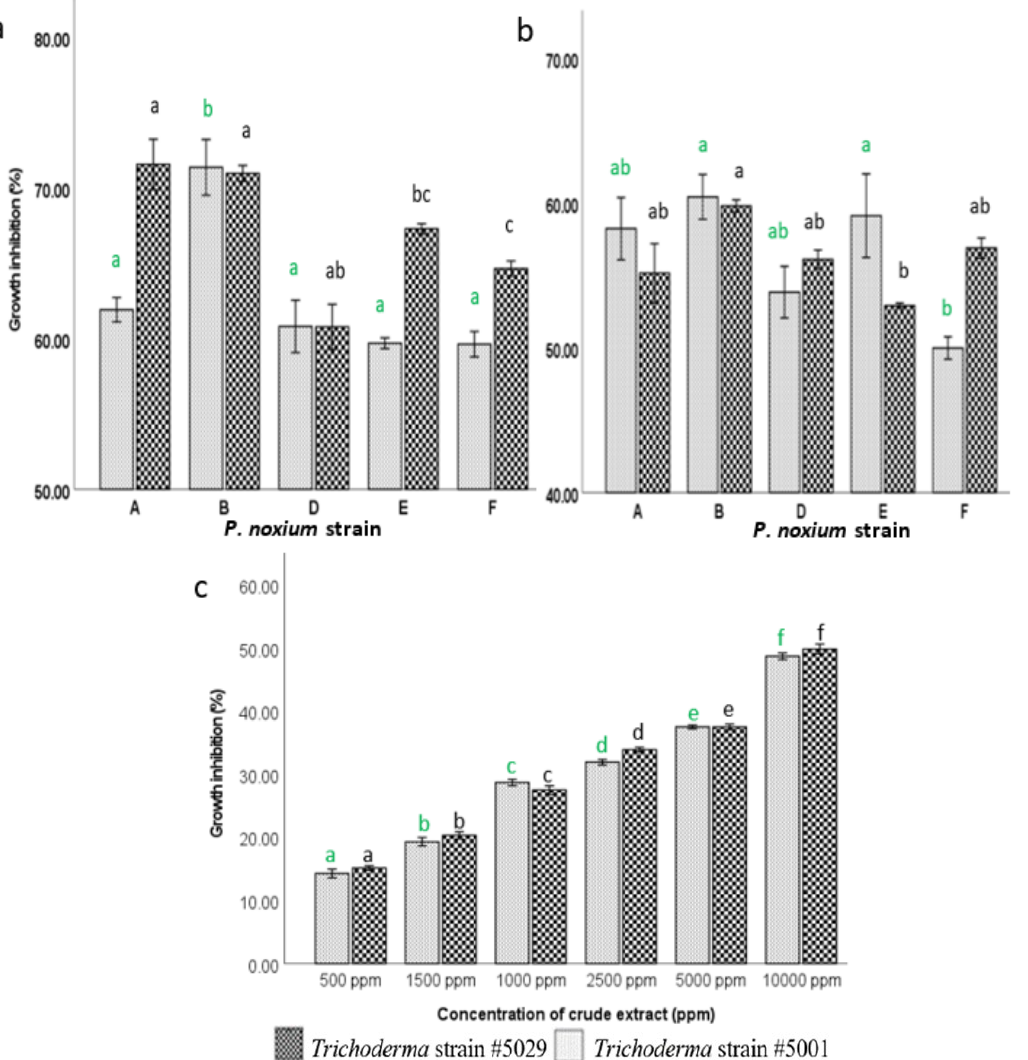
Figure 3. Growth inhibition % of P. noxium (strains: A, B, C, D, E and F) ( a ) during the confrontation with Trichoderma strains #5001 and #5029 in dual culture set up; ( b ) by the volatile compounds of Trichoderma strains #5001 and #5029; ( c ) growth inhibition % of P. noxium strain B by the crude extracts of the Trichoderma strains #5029 and #5001 at different concentrations. Different letters with the same color on the top of SE bars indicate significant differences in growth inhibition observed between P. noxium strains caused by the particular Trichoderma strain based on Tukey’s test, p < 0.05.